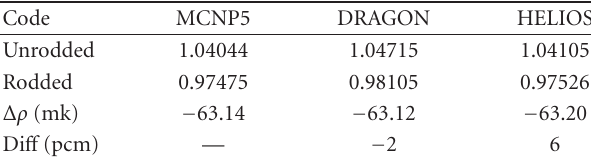
Table 1: CNA-I idealized circular lattice results.